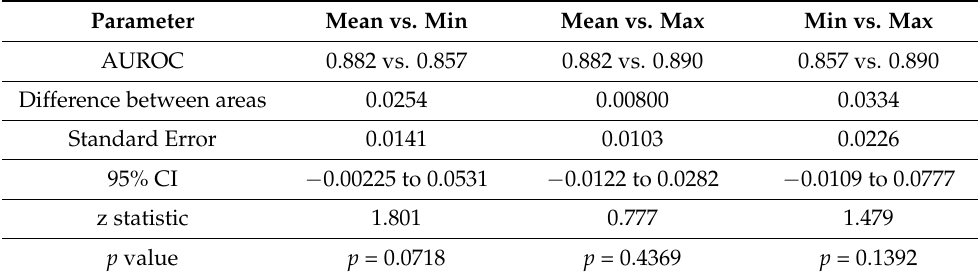
Figure 4. Comparison between receiver operating characteristic for TS values, using mean TS values, the highest TS values and the lowest TS values. Table 3. The difference between areas under receiver operating characteristic curves (AUROCs) for the established cut-off